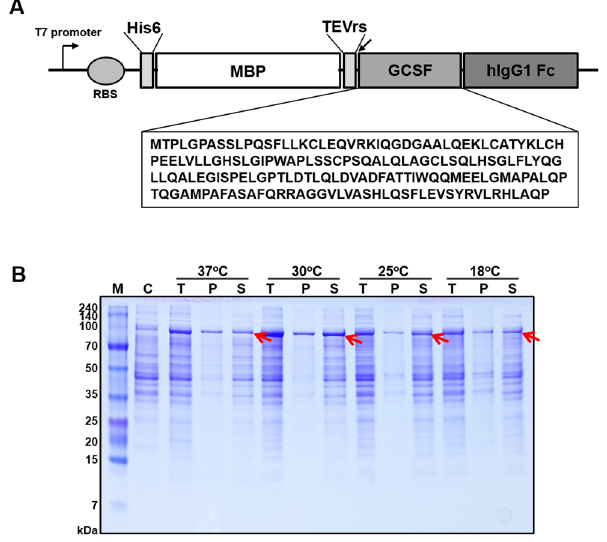
Figure 1. Schematic representation of MBP fused GCSF-Fc construct ( A ) and expression of MBP fused GCSF-Fc at different temperatures ( B ). GCSF gene was fused with a C-terminal IgG1 Fc domain and an MBP tag at the N-terminus. The expression was controlled by the T7 promoter. Arrow between GCSF and MBP indicates TEV cleavage site. His6 is N-terminal to the MBP tag. MBP-GCSF-Fc expression was induced by 0.5 mM IPTG at: 18°C, 25°C, 30°C or 37°C. Arrows indicate the target fusion proteins. The abbreviations are as follows: RBS, ribosome binding site, M, molecular weight marker; C, total cell protein before IPTG induction as a negative control; I, total cell protein after IPTG induction; P, pellet fraction after cell homogenization; S, soluble fraction after cell